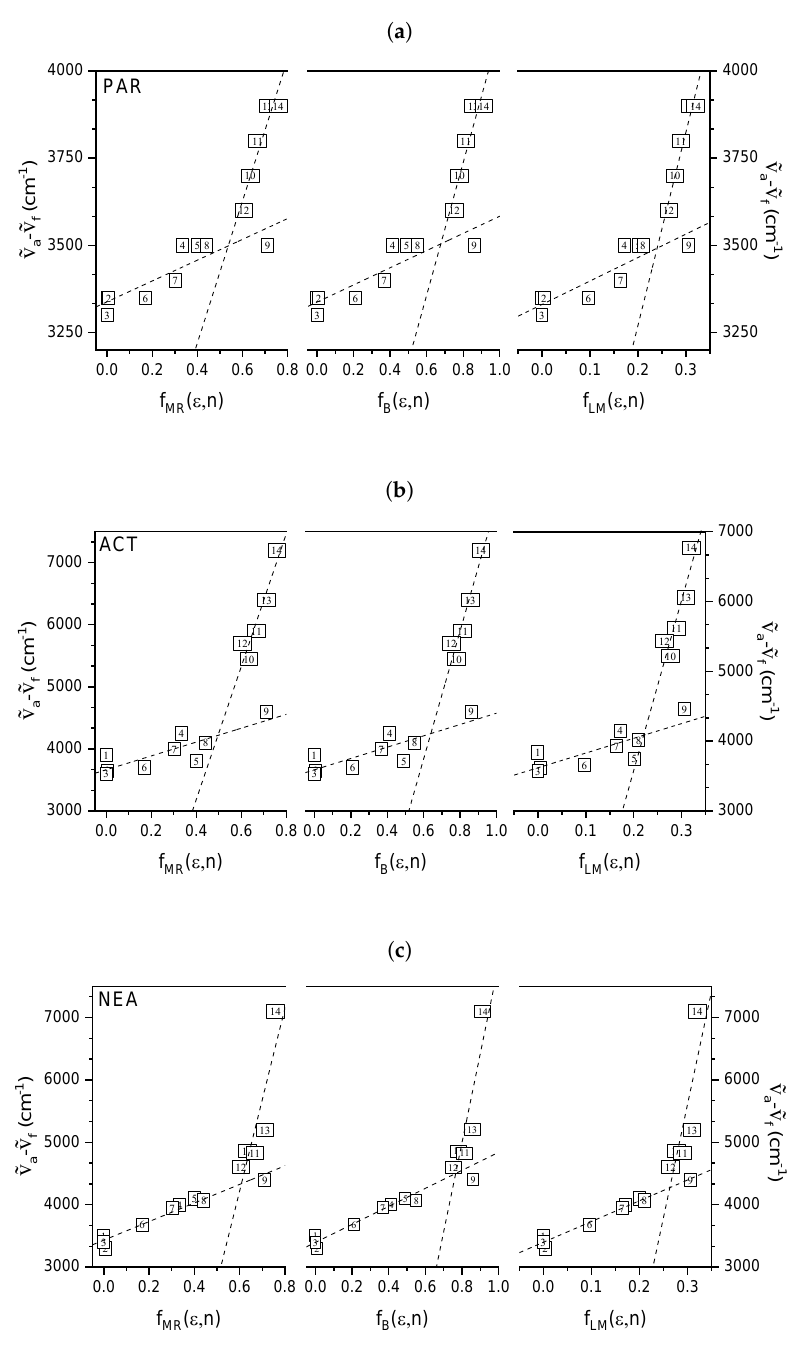
Figure 5. Stokes shifts ( ˜ ν a − ˜ ν f ) versus solvent polarity functions ( f MR ( ε , n ) , f B ( ε , n ) , f LM ( ε , n ) ) for three tested molecules: ( a ) paracetamol (PAR), ( b ) acetanilide (ACT), and ( c ) N -ethylaniline